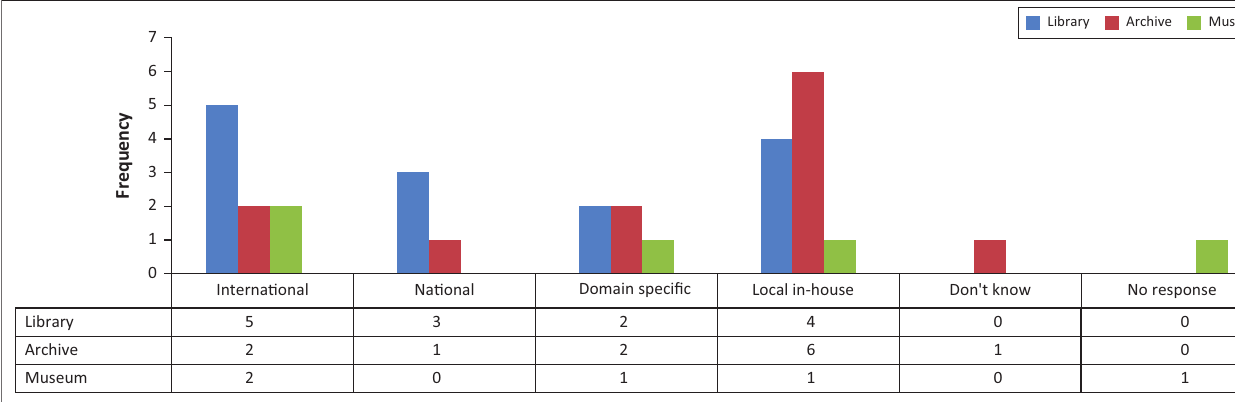
FIGURE 5: Metadata standards ( N = 17).